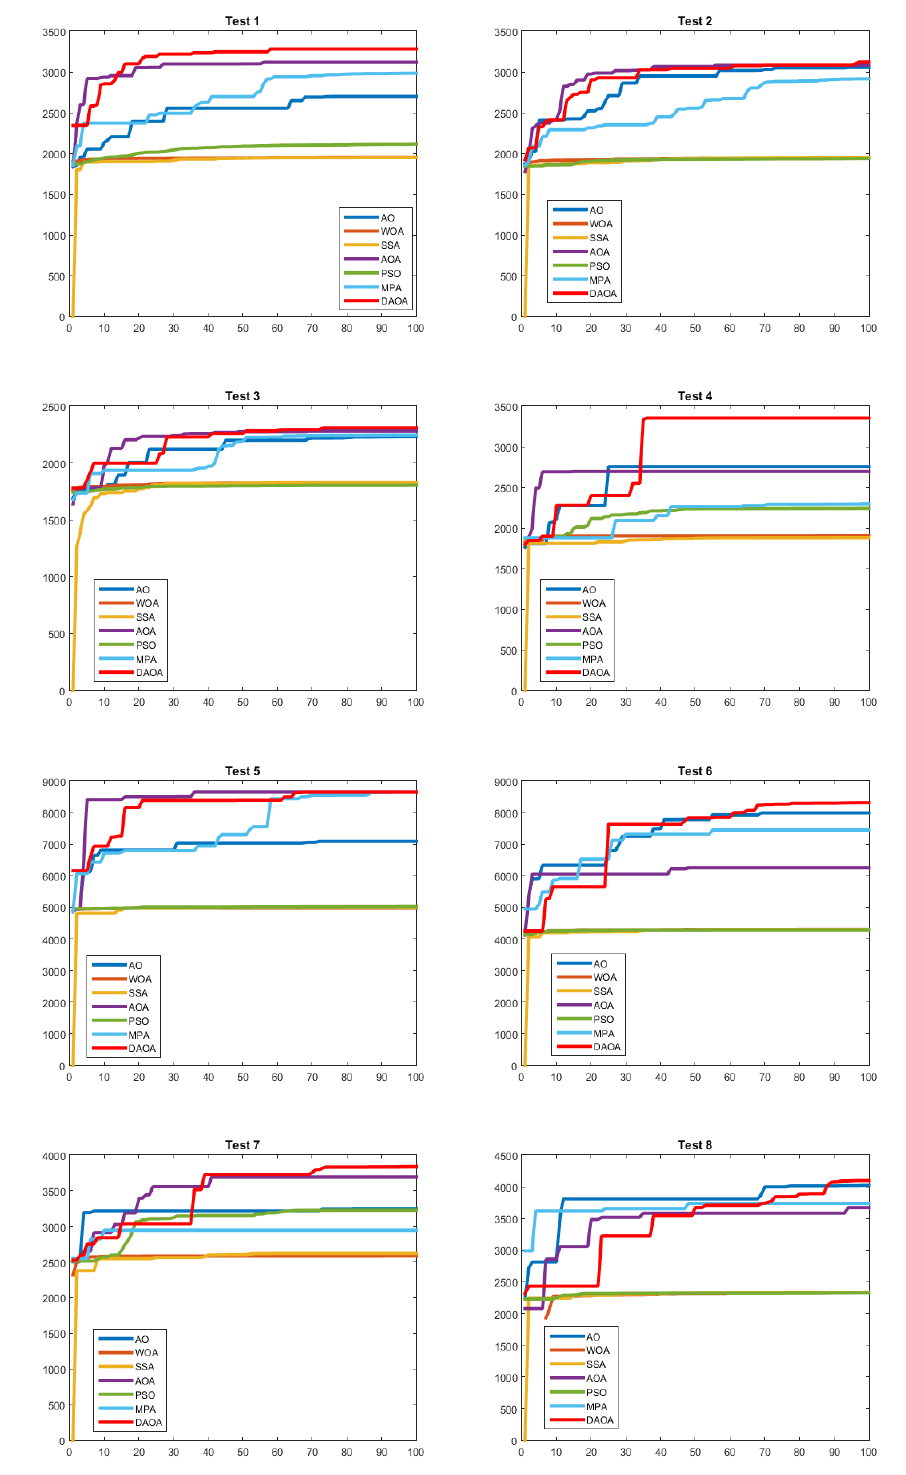
Figure 16. The convergence behavior of the comparative methods in solving Test 8 when the threshold value is